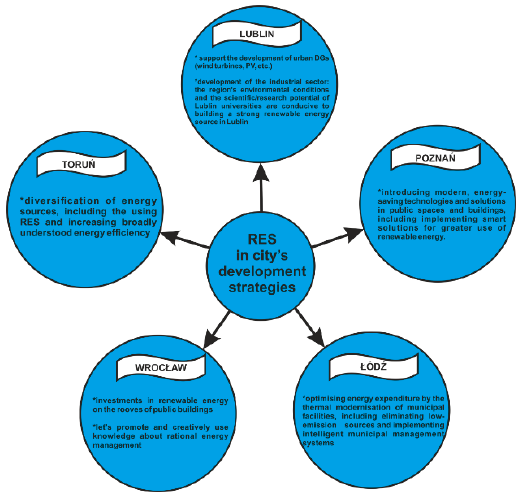
Figure 4. RES in urban development strategy. Source: own study based on urban development strategies [88–107].